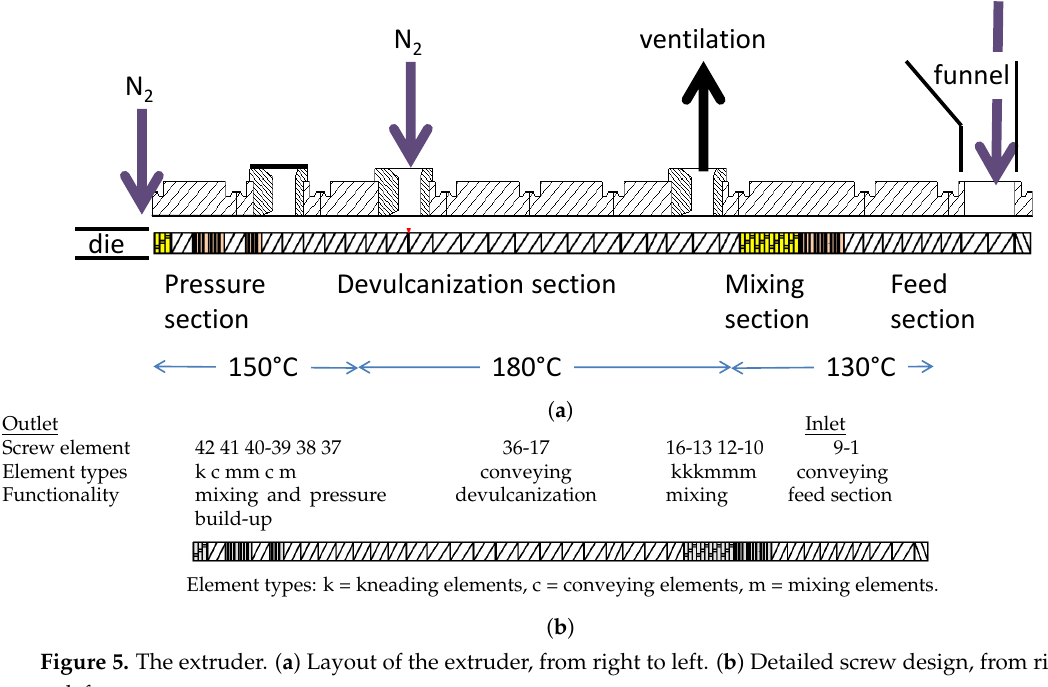
Figure 5. The extruder. ( a ) Layout of the extruder, from right to left. ( b ) Detailed screw design, from right to left.